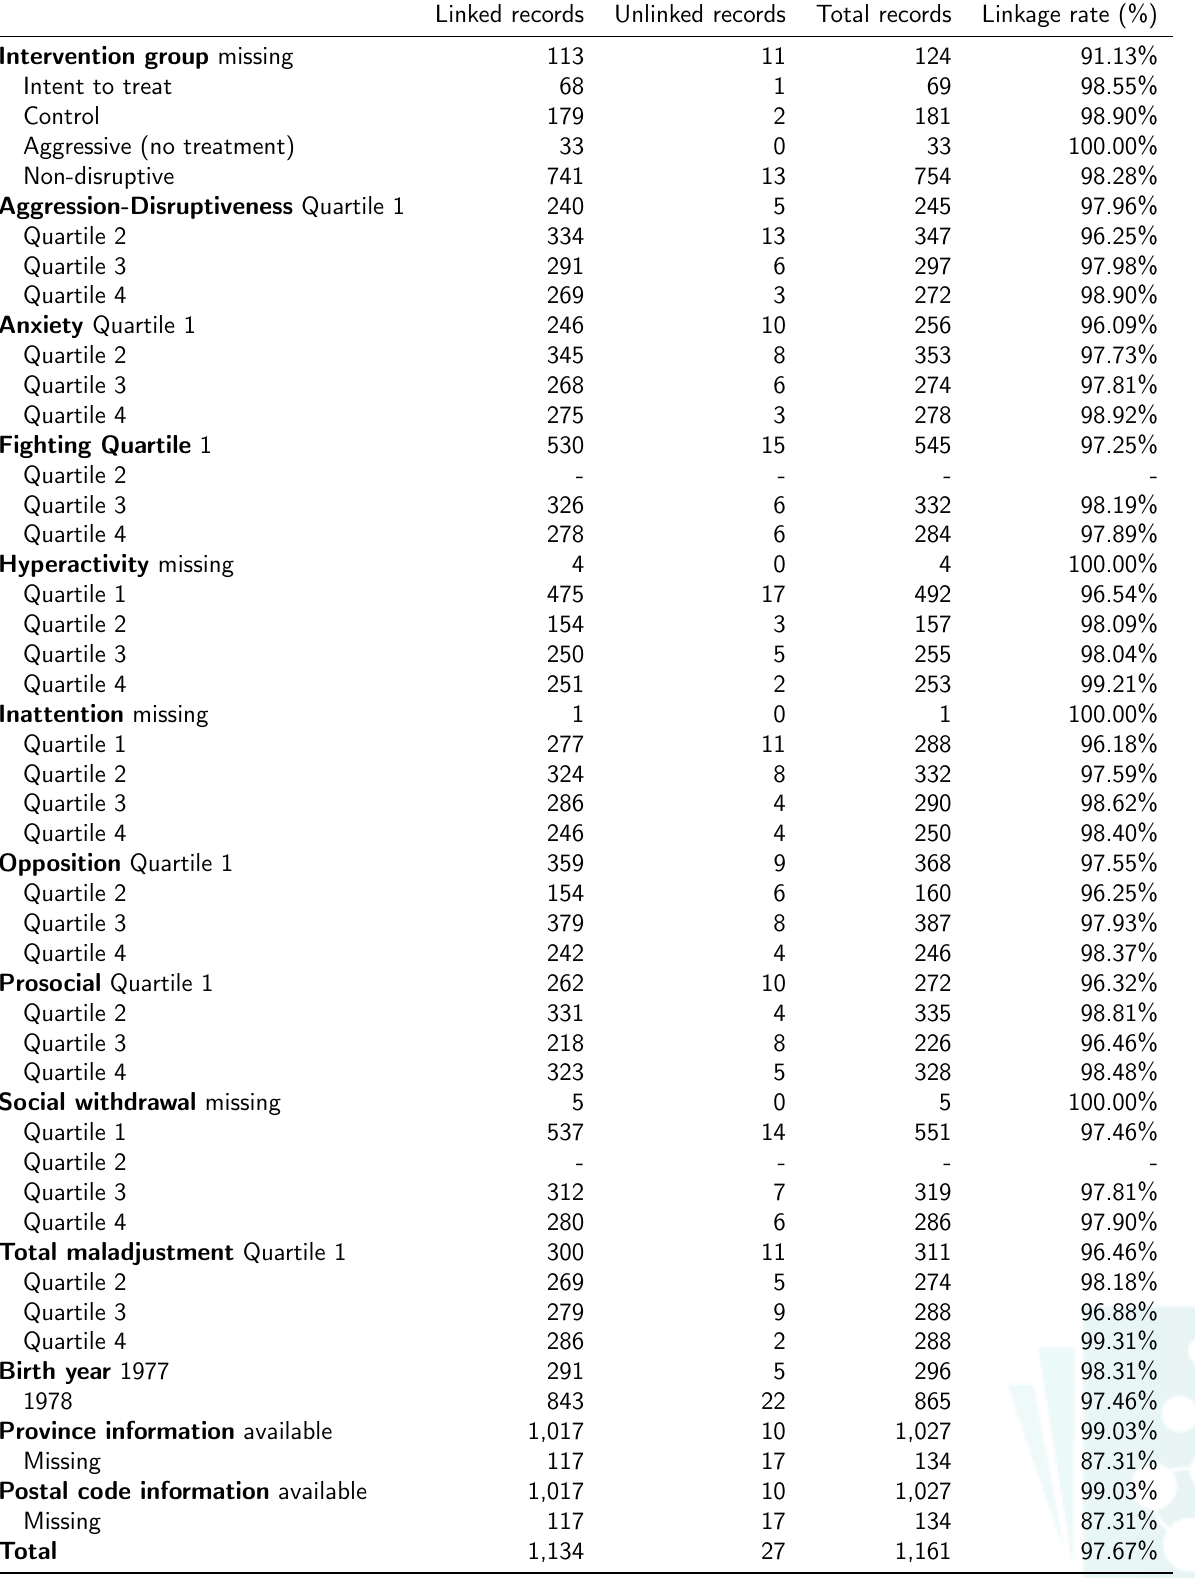
Table 2: Linkage rates for the MLES cohort to the DRD Linked